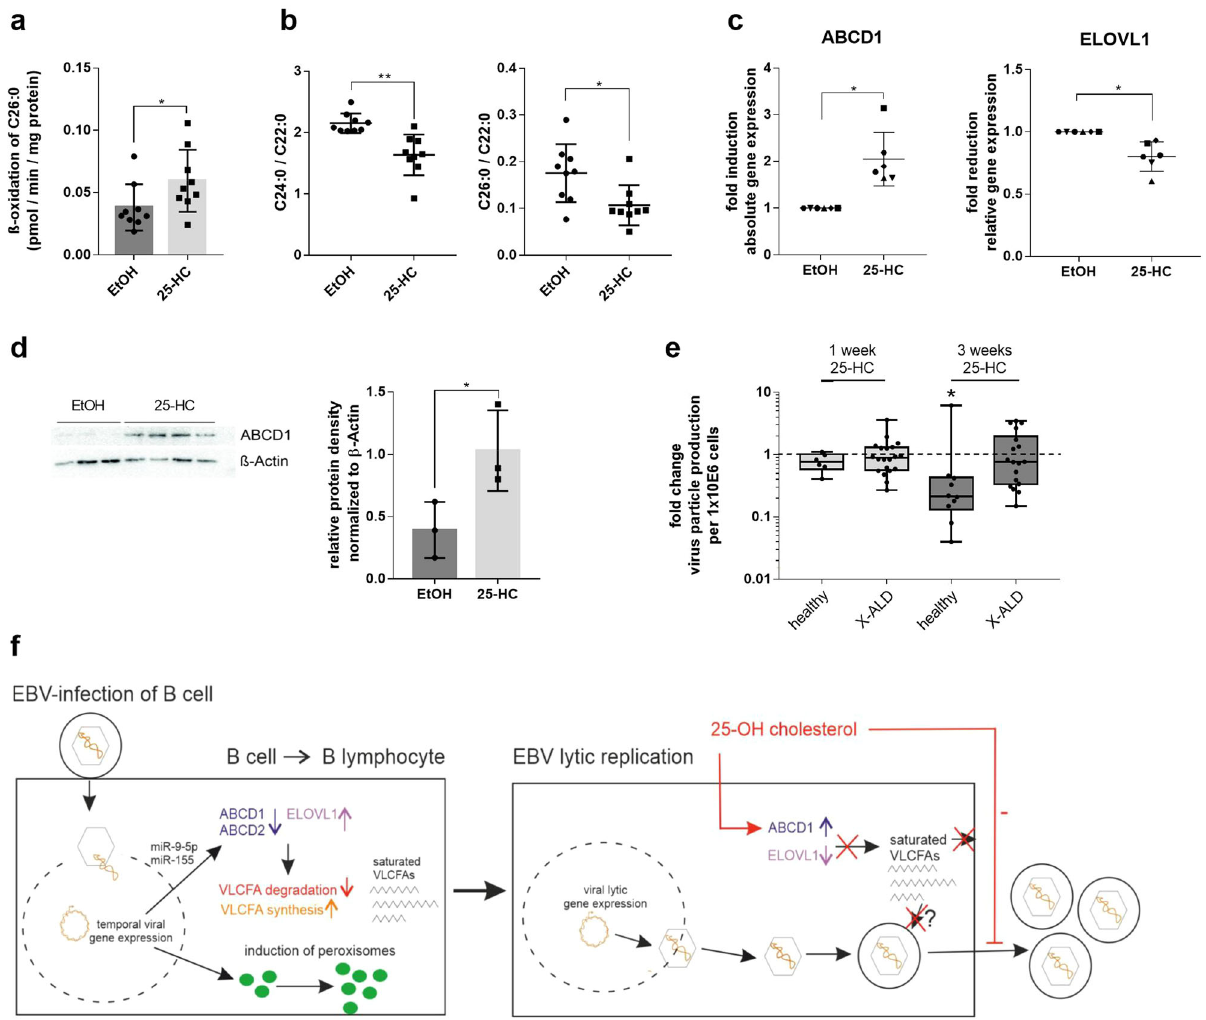
Fig. 5 The antiviral mediator 25-hydroxycholesterol lowers cellular VLCFA levels and interferes with EBV reproduction. In vitro EBV-infected and immortalized B lymphocytes from healthy controls were supplemented with either 25-HC (2 µ M) or vehicle (ethanol, EtOH). a After 48 h, the degradation of C26:0 was determined and displayed as the C26:0 β -oxidation rate normalized to protein content ( n = 9). The bar graphs show mean ± S.D. of the indicated values. b The cellular amounts of C22:0, C24:0 and C26:0 were determined by GC-MS after 3 weeks of treatment. The levels of C24:0 and C26:0 are displayed as ratio to C22:0 ( n = 9). The mean is indicated by a horizontal line ± S.D. c RNA was isolated after 24 h and RT-qPCR was carried out for ABCD1 and ELOVL1 ( n = 6). The mean is indicated by a horizontal line ± S.D. Data were normalized to HPRT mRNA levels and displayed as fold change compared to vehicle-treated cells. d Protein extracts for Western blot analysis were prepared after 48 h of supplementation with 25-HC or EtOH. The relative amount of ABCD1 protein was normalized to the β -actin level. One representative immunoblot from one B lymphocyte line with 3 (untreated) and 4 (25-HC treated) technical replicates is shown; quanti fi cation was conducted using three different B lymphocyte lines. The bar graphs show mean ± S.D. of the indicated values. Uncropped western blot images are shown in Supplementary Fig. 8. e EBV-immortalized B lymphocytes derived from X-ALD patients ( n = 18 – 20) or healthy controls ( n = 6 – 10) were treated with either 25-HC (2 µ M) or EtOH for either 1 or 3 weeks before lytic virus replication was induced by PMA/sodium butyrate. EBV particle number was determined in the cell free supernatant by qPCR for BALF5 in the EBV genome. The data are depicted as boxplots (median ± interquartile range). For statistical analysis, two-tailed paired Student ’ s t -test was used (* P ≤ 0.05, ** P ≤ 0.01). In ( c ) and ( e ), the raw values used to generate the fold-change display were used for statistical analysis. f Model of EBV targeting VLCFA metabolism and peroxisomes (left panel) and how 25-HC impedes viral reproduction (right panel). EBV infection of B cells results in rapid miRNA-mediated downregulation of the peroxisomal VLCFA importers ABCD1 and ABCD2. This occurs despite a general induction of peroxisome-related genes such as those encoding proteins involved in peroxisome proliferation and biogenesis (c.f. Fig. 2e), possibly indicating increased peroxisome numbers. The impaired peroxisomal degradation of VLCFAs but concurrent upregulation of VLCFA synthesis via the fatty acid elongase ELOVL1 leads to increased cellular VLCFA levels, possibly necessary to establish latency. Upon stimulation of EBV lytic replication, the antiviral metabolite 25-hydroxycholesterol interferes with EBV reproduction, among other, by opposite regulation of ABCD1 (up) and ELOVL1 (down), thus resulting in net VLCFA catabolism and preventing cellular accumulation of EBER in situ hybridization . EBER in situ hybridization was performed using a Biotin-labelled donkey anti-mouse secondary antibodies (#715-065-150, Jackson commercially available kit. Brie fl y, formalin- fi xed, paraf fi n-embedded sections ImmunoResearch Laboratories, West Grove, PA) for 1 h at room temperature and were hybridized with the Inform EBER probe (#05278660001, Roche Diagnostics) detection with avidin-labelled peroxidase (Sigma, 1:150) and diaminobenzidine and the VENTANA ISH iView Blue Detection Kit was used for visualization tetrachloride (DAB, Sigma). A hematoxylin counterstain was performed to visua- (#05278511001, Roche Diagnostics). The staining procedures were performed in a lize nuclei.